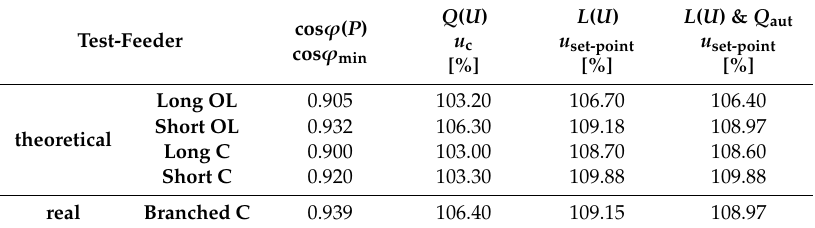
Energies 2019 , 12 , x FOR PEER REVIEW 25 of 27 Table A1. Line parameters of LV test-feeders. Line Type